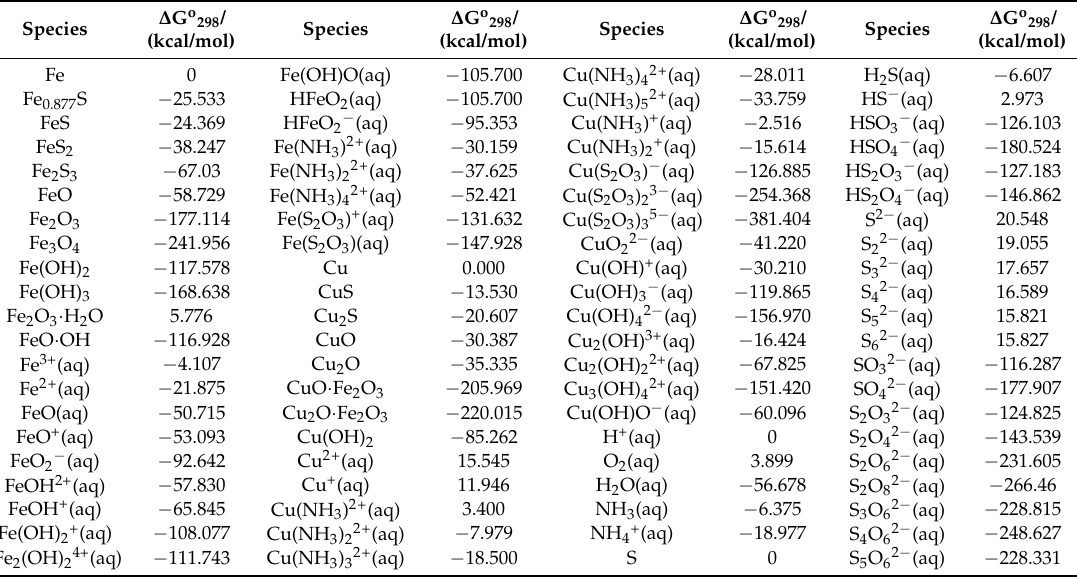
Table A1. Free energies of formation (kcal/mol) for species of iron, copper, sulfur,